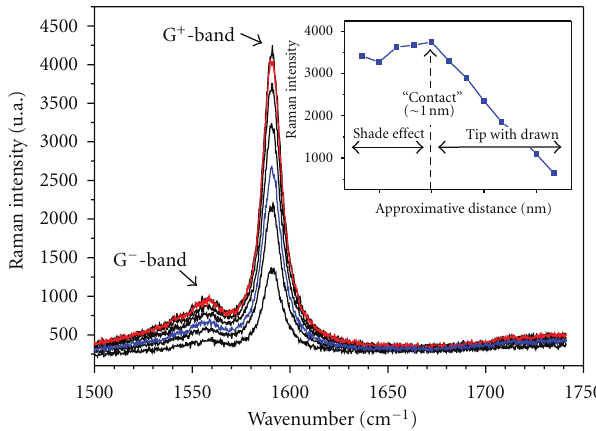
Figure 6: TERS signal recorded on an individual SWCNT placed on the surface. Raman spectra are recorded for di ff erent tip-SWCNT distance (excitation line: 647.1 nm; laser power: 10 mW/ μ m 2 expo- sure time: 30 seconds). The inset indicate the intensity of the experimental Raman as a function of the estimated tip-SWCNT